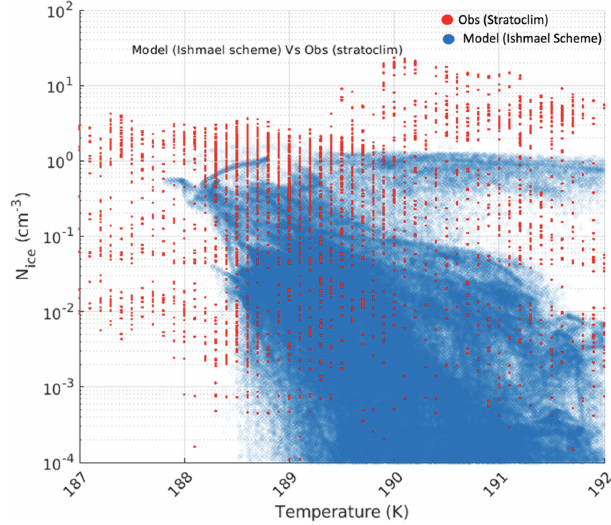
Figure 10. Simulated (blue) and observed (red dots) N ice versus temperature at 17km using the ISHMAEL